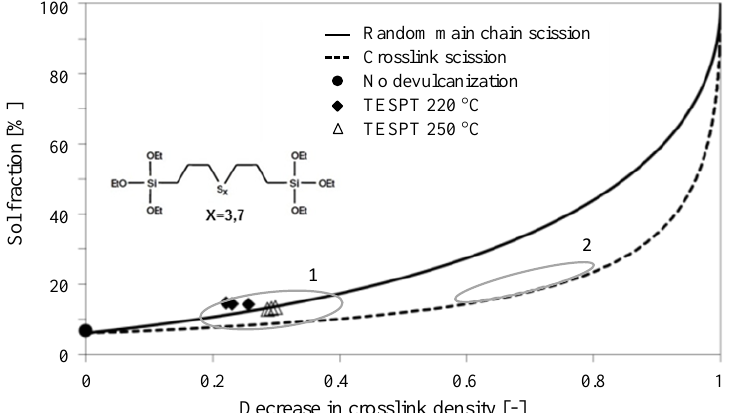
Figure 6. Degree of devulcanization of a silica-based tire tread compound as shown by a Horikx-Verbruggen diagram. 1 = Measurements for silica-based devulcanizates, as measured by Saiwari [14], 2 = Range of best devulcanized carbon black-based samples [5].